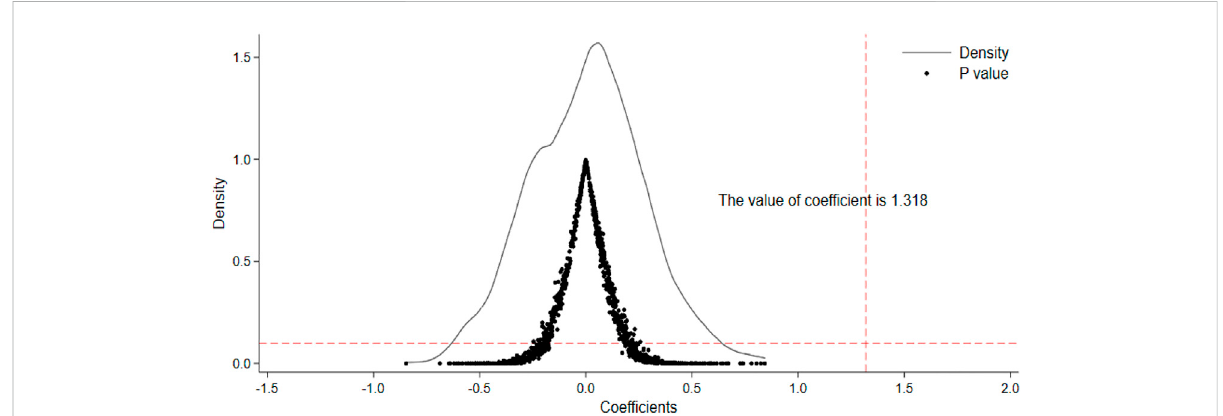
FIGURE 4 The placebo effects of thelow-carbon city pilot policy. Note: The fi gures show the distribution of estimated coef fi cients and corresponding p -values of the pseudo-low-carbon city pilot dummy variables sampled 1,000 times. The vertical dashed line represents the estimated value of the true coef fi cient, while the horizontal dashed line represents a value of 0.1.